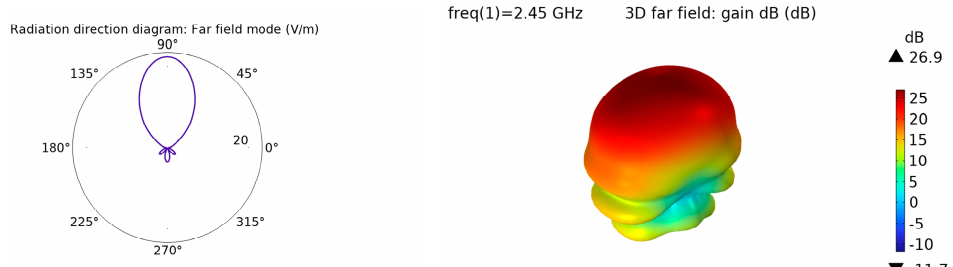
Figure 2. Horn antenna radiation direction diagram.